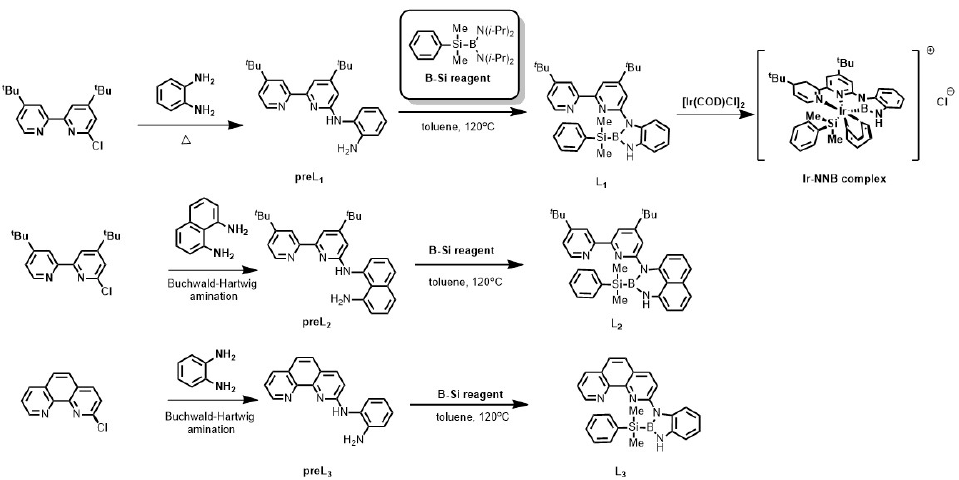
Scheme 3. Preparation of the NNB ligand and the oxidative addition with [Ir(COD)Cl] 2. and NNB